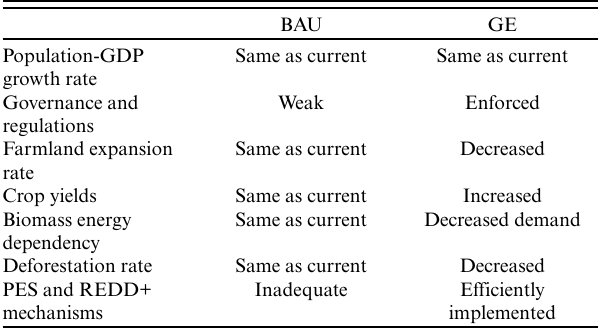
Table 1 . General definitions for business as usual (BAU) and green economy (GE) scenarios proposed to participants of multistakeholder